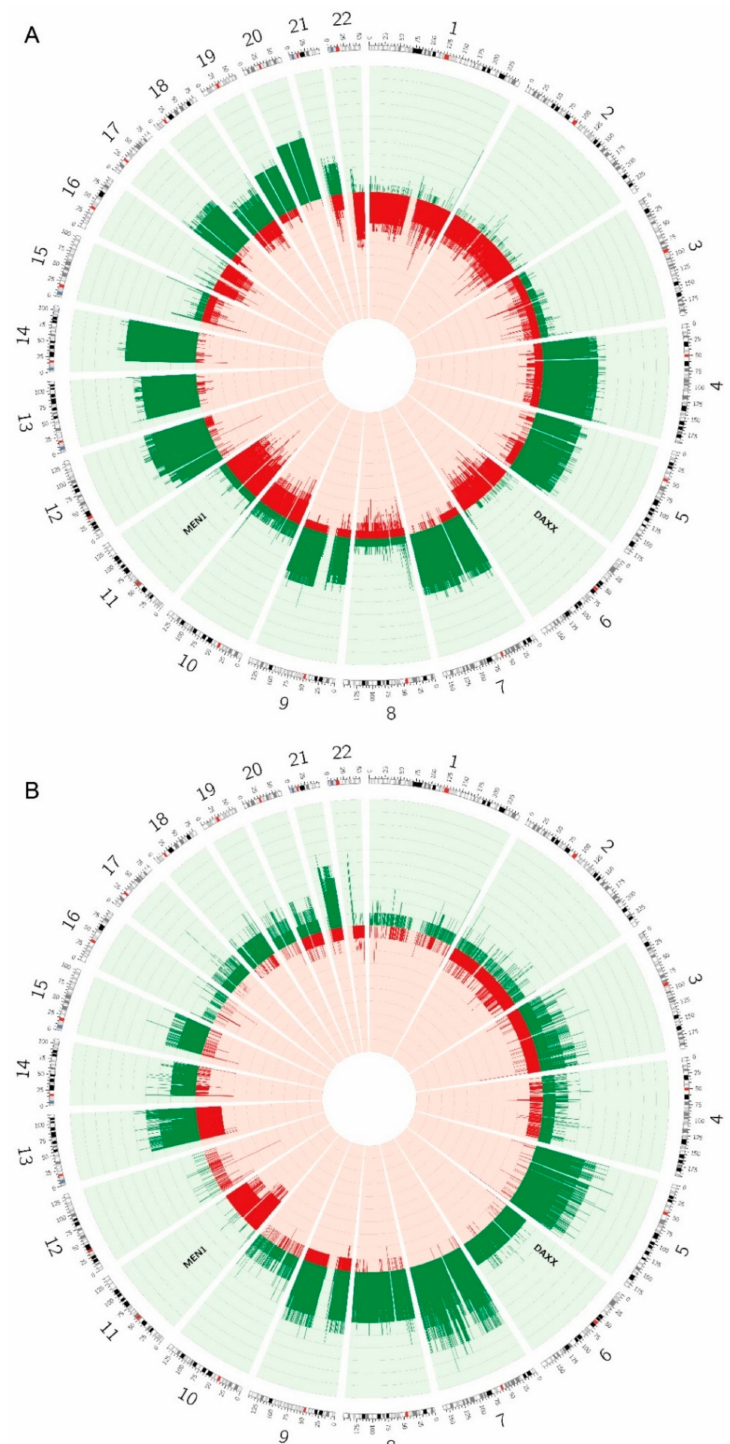
Figure 5. Circos plots of the frequency of copy number alterations observed in PNENs of ( A ) subtype A and ( B ) subtype B. Gains are indicated in green and losses in